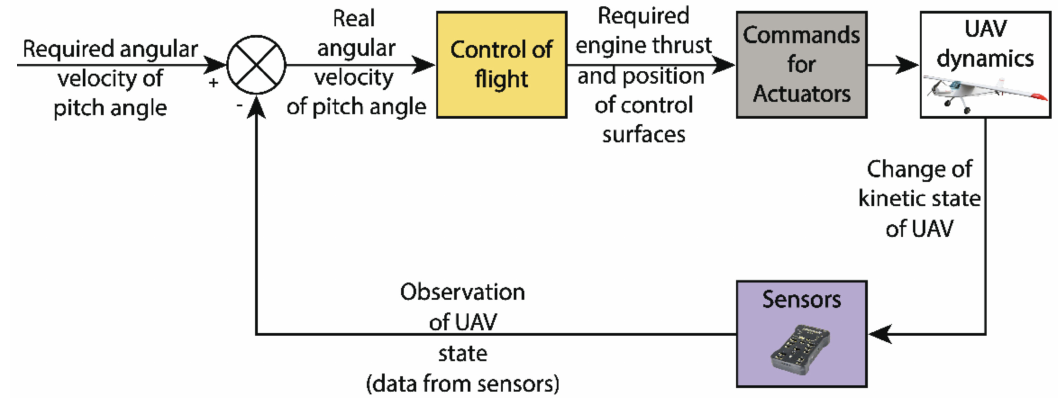
Figure 3. Block diagram of the UAV control